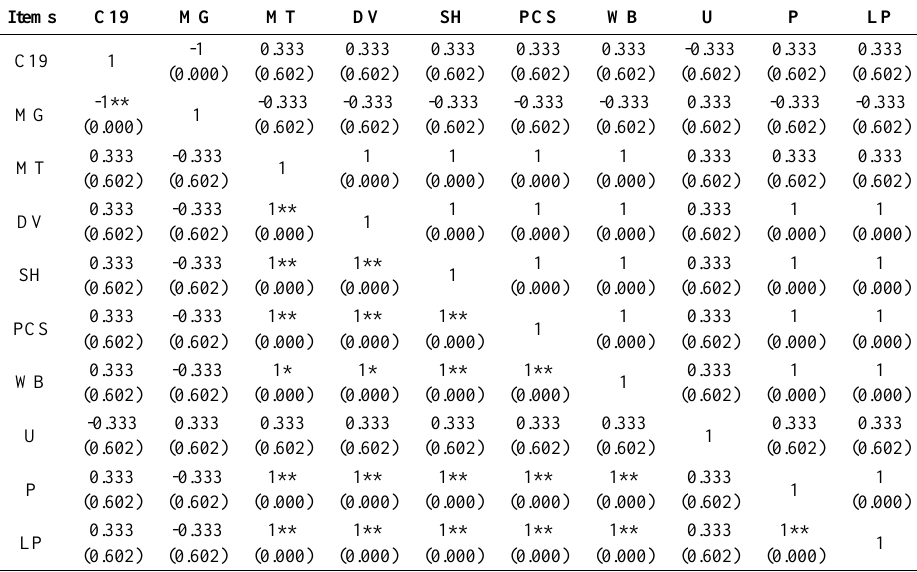
Table 4. Summary of Kendall's Tau correlation (**p <0.01)